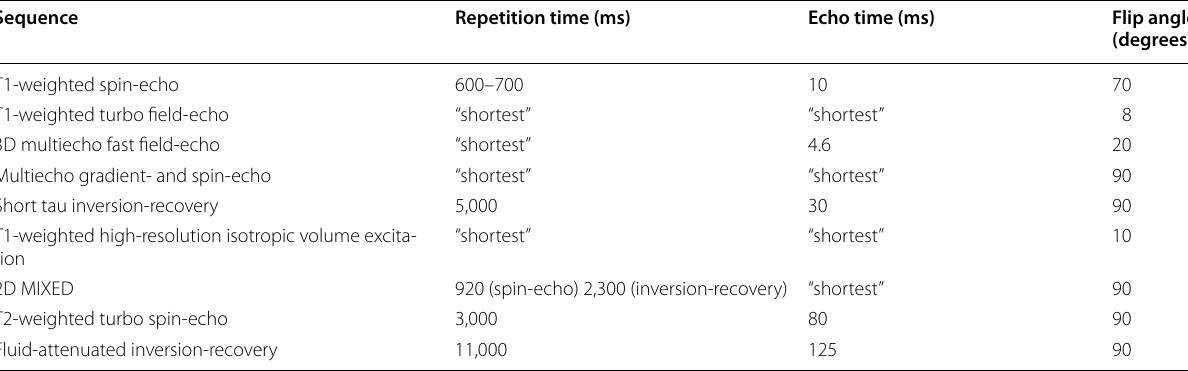
2D Two-dimensional, 3D Three-dimensional